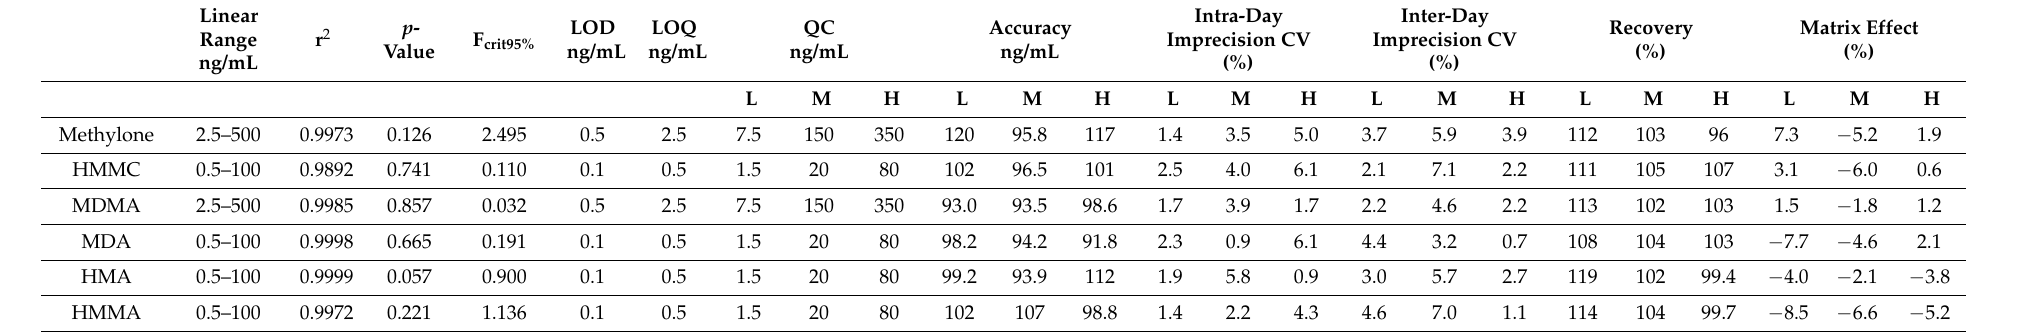
Table 1. Method validation parameters and Mandel’s fitting test ( p -value and Fcrit95%) for analytes under investigation in plasma